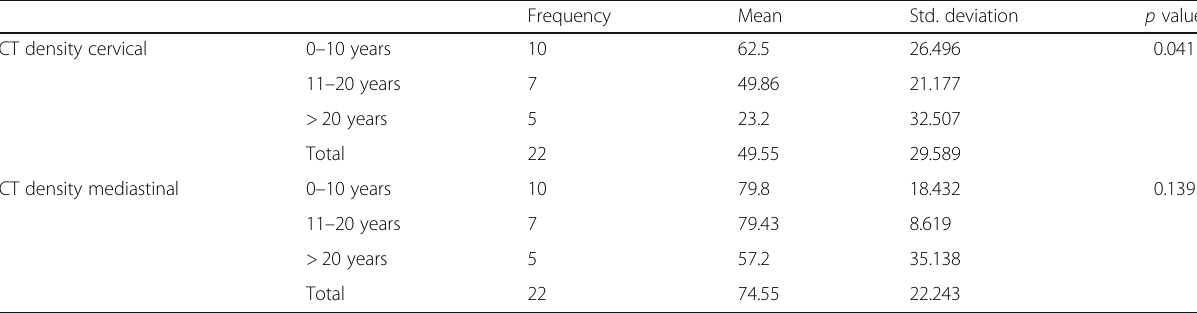
Table 4 Comparison of CT densities of cervical and mediastinal thymus with age by ANOVA test Frequency Std.